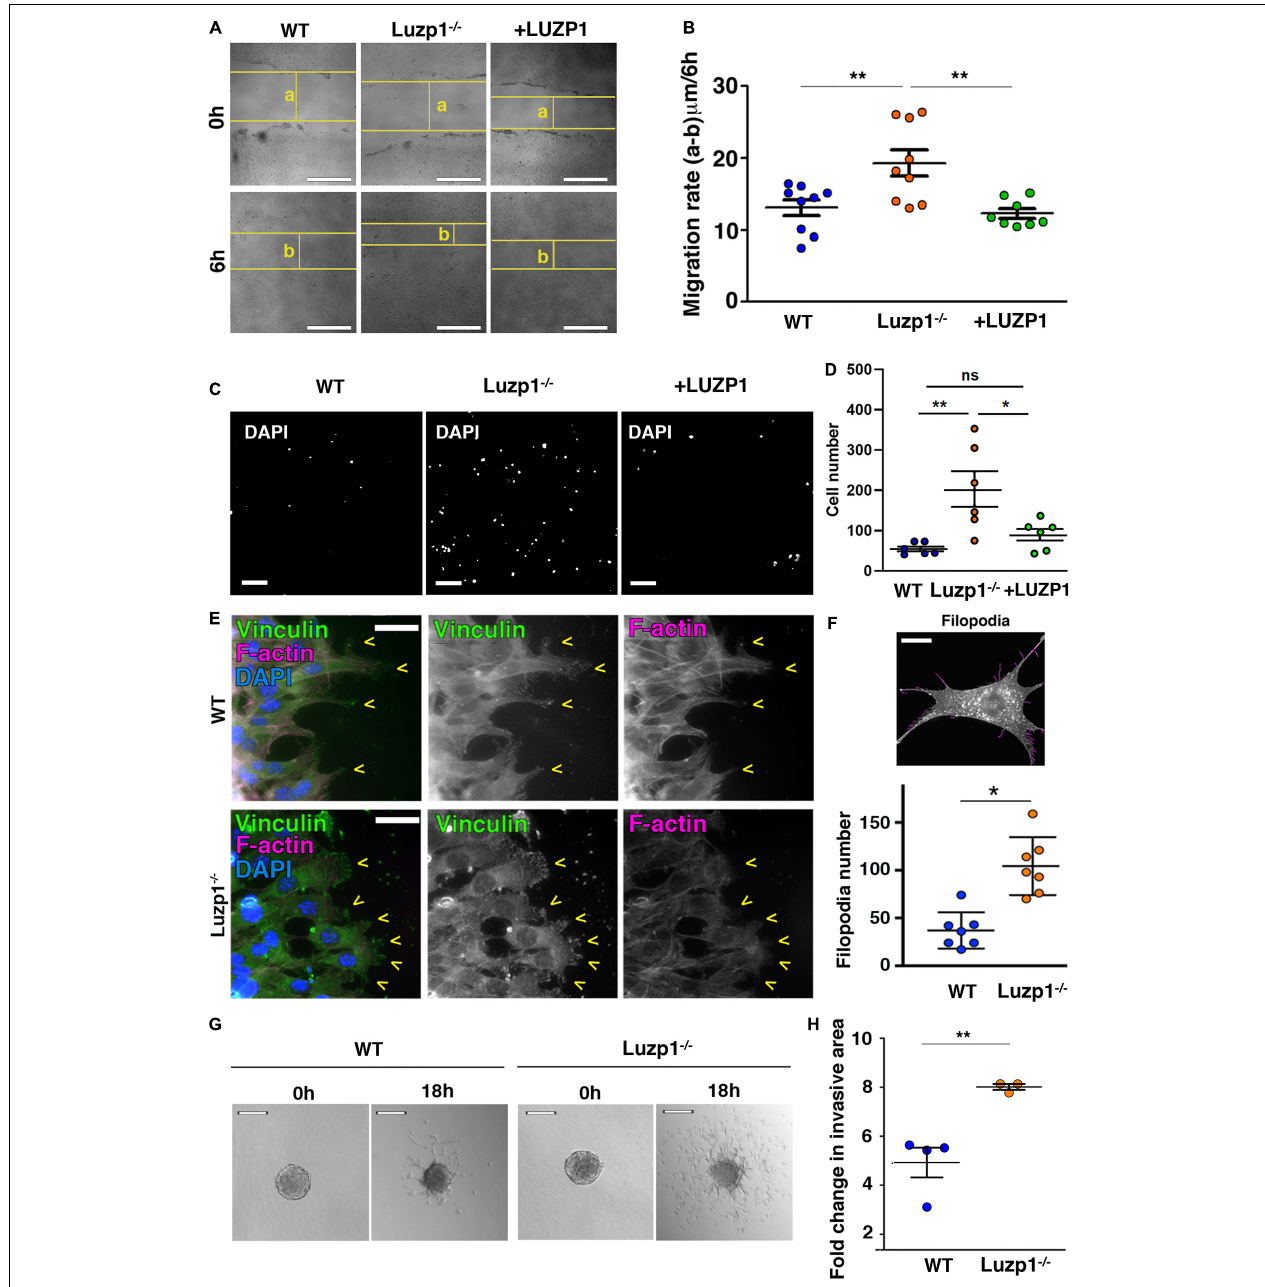
FIGURE 2 | Luzp1 − / − cells exhibit cell migration and invasion defects. (A) Representative bright-field micrographs of the wound healing assays performed on Shh-LIGHT2 WT, Luzp1 − / − and Luzp1 − / − cells rescued with Luzp1-YFP (+ LUZP1). The horizontal yellow lines represent the wound boundary; “a” and “b” are the distances between wound boundaries just after wound was made (0 h) and 6 h later (6 h), respectively. Scale bar, 200 µ m. (B) Quantification of wound healing in (A) calculated by subtracting distance “b” to distance “ a” and dividing the result by 6 h ( n > 8). Data were analyzed by One-way ANOVA and Bonferroni post hoc test. (C) Representative images of migrating cells of a transwell assay are shown. Cells were detected by DAPI (white). Scale bar, 100 µ m. (D) Graph representing the number of migrating cells. (E) Micrographs of WT and Luzp1 − / − cells during wound healing assay. Focal adhesions were detected by anti-vinculin antibody (green), F-actin by phalloidin (magenta) and nuclei by DAPI (blue). Yellow arrowheads point at lamellipodia. Black and white images show the single green and magenta channels. Scale bar, 10 µ m. (F) Upper panel: example of filopodia detection by Filoquant plugin for ImageJ (in magenta) from an original picture of a Luzp1 − / − cell (in black and white). Scale bar, 5 µ m. Lower panel: graphical representation of filopodia number of WT ( n = 7; blue dots) and Luzp1 − / − cells ( n = 7; orange dots). Imaging was performed using widefield fluorescence microscopy (Zeiss Axioimager D1, 63x objective). P -value was calculated using Mann Whitney test. (G) Invasive growth of WT or Luzp1 − / − cells was analyzed in 3D collagen matrix. Images were taken at t = 0 h and t = 18 h. Representative images are shown. Scale bar, 25 µ m. (H) Representation of the fold change in invasion resulting of dividing the area covered by the cells at t = 18 h by the area covered by the cells at t = 0 h. Data were analyzed by ANOVA and Bonferroni post hoc test or Student’s t -test. The graphs in (B,D,F) represent the Mean and SEM. Data were analyzed by ANOVA and Bonferroni post hoc test or Student’s t -test. ∗ P < 0.05; ∗∗ P < 0.01.